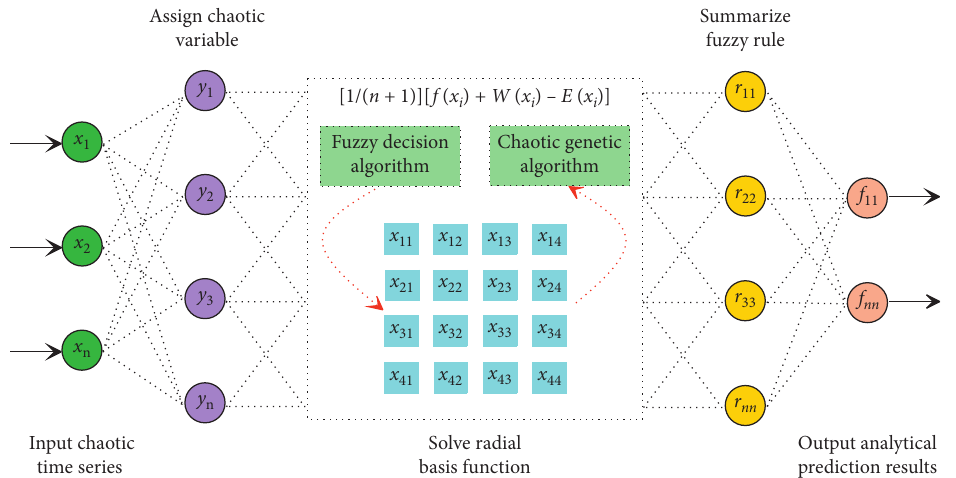
Input chaotic time series Figure 4: Economic chaotic time series prediction processes based on chaotic genetics combined with fuzzy decision